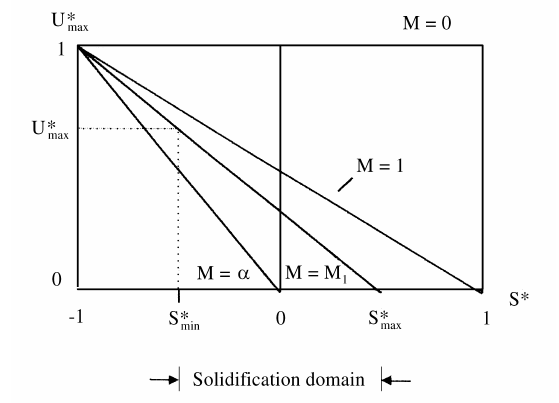
Figure 6. Schematic representation of the solidification domain gene- rated by a thermal shock by a mold with M = M 1